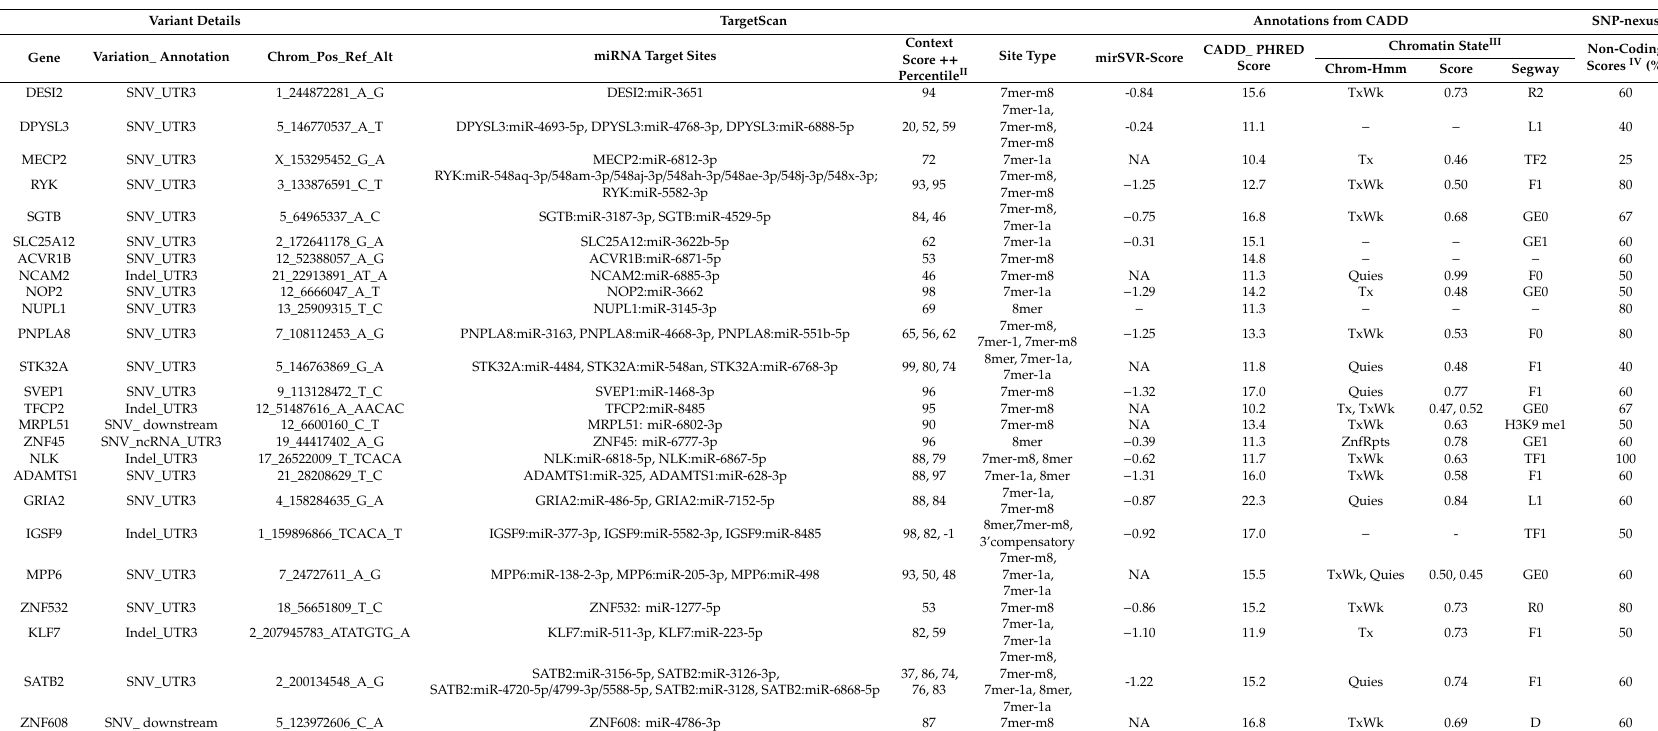
Table 3. Top downstream and 3 (cid:48) UTR variants prioritized according to the FCVPPv2. Variant annotation, chromosomal position, and regulatory consequences according to TargetScan, CADD and SNPnexus are listed. Information on miRNA target sites from TargetScan and chromatin states from CADD are also included. A cumulative non-coding score is shown as a percentage of positive scores from all scores listed in the footnote. Cut-o ff s for these scores are also indicated in the